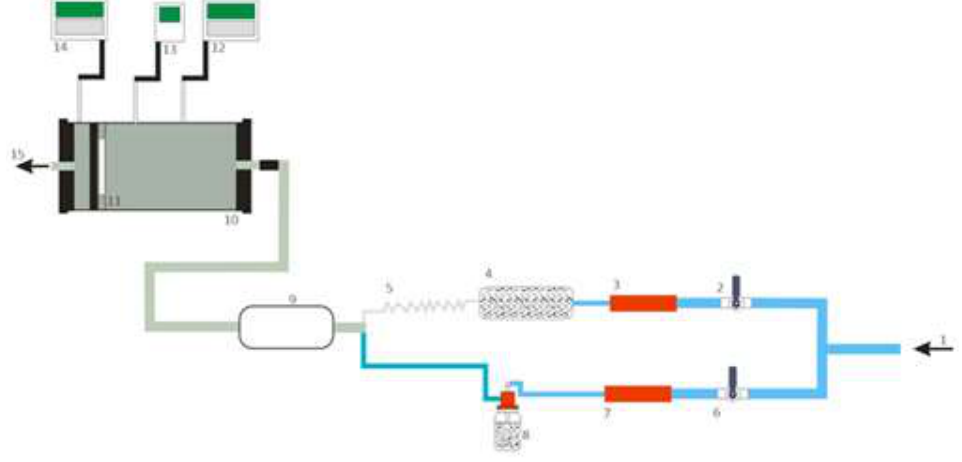
Figure 2. Experimental station for testing the protection time of half-masks against chemical